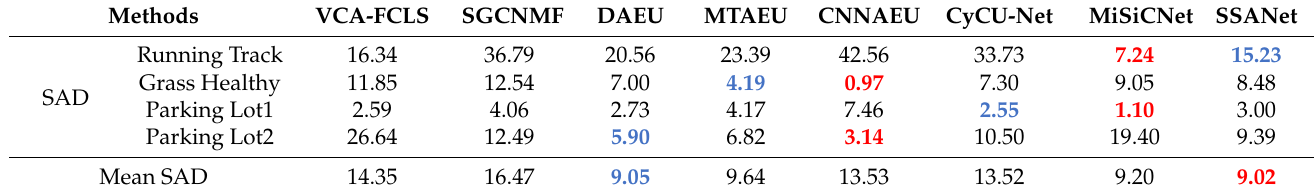
Table 7. SAD ( × 100) and mean SAD ( × 100) of endmembers acquired by various unmixing ap- proaches on Houston data. Annotation: bold red text indicates the best results and bold blue text indicates the suboptimal results.